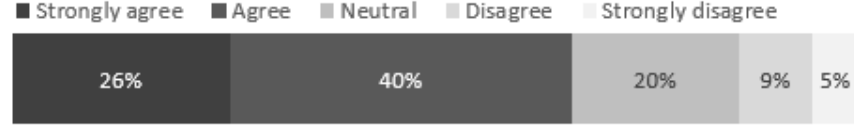
Figure 3: Substantial agreement that the VLE app is